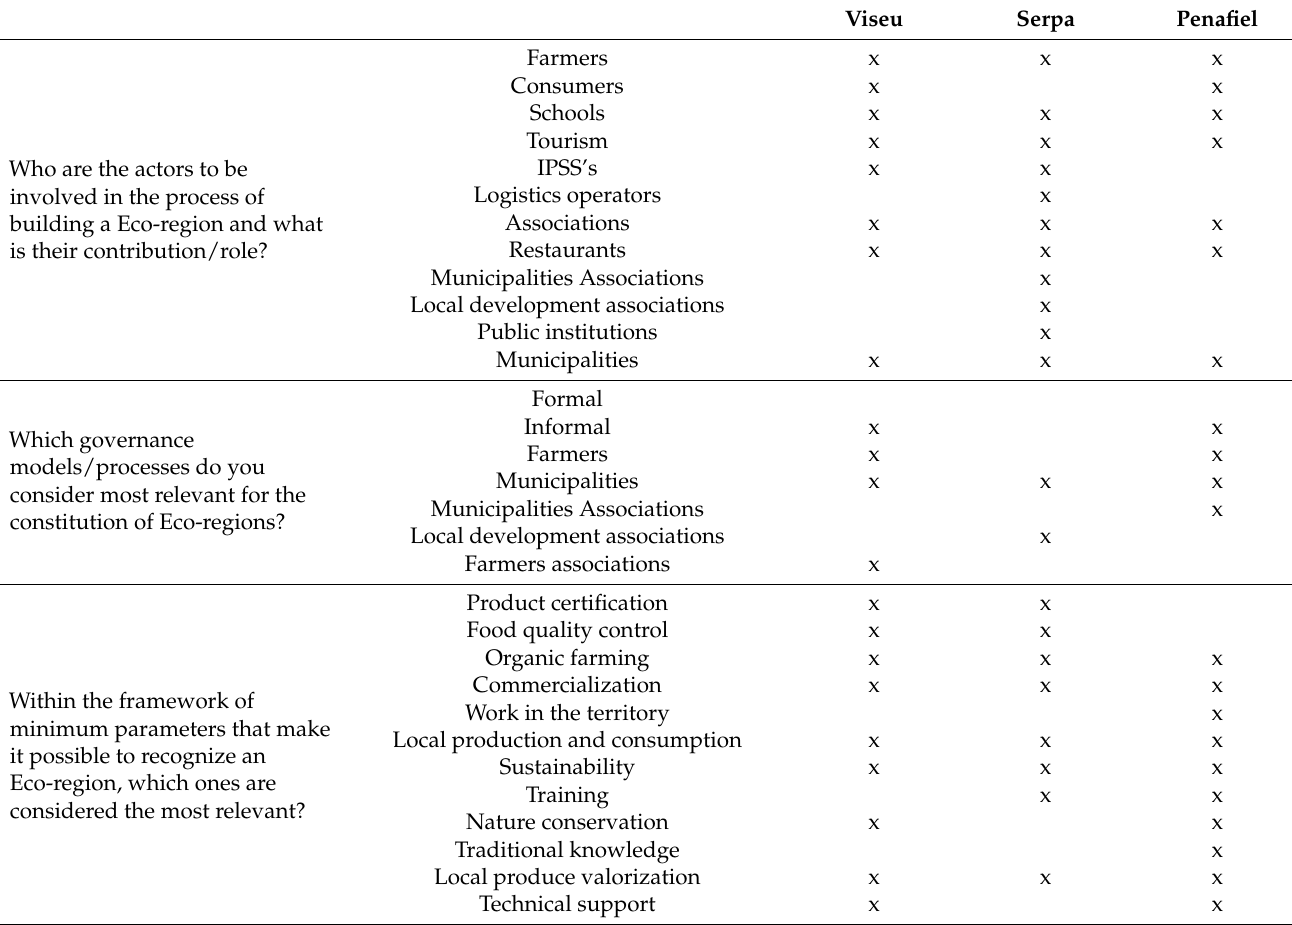
Table 5. Results of the Focus Groups organized in Viseu, Serpa and online in 2020 under the project “Eco-regions: an integrated strategy for the development of rural territories”.